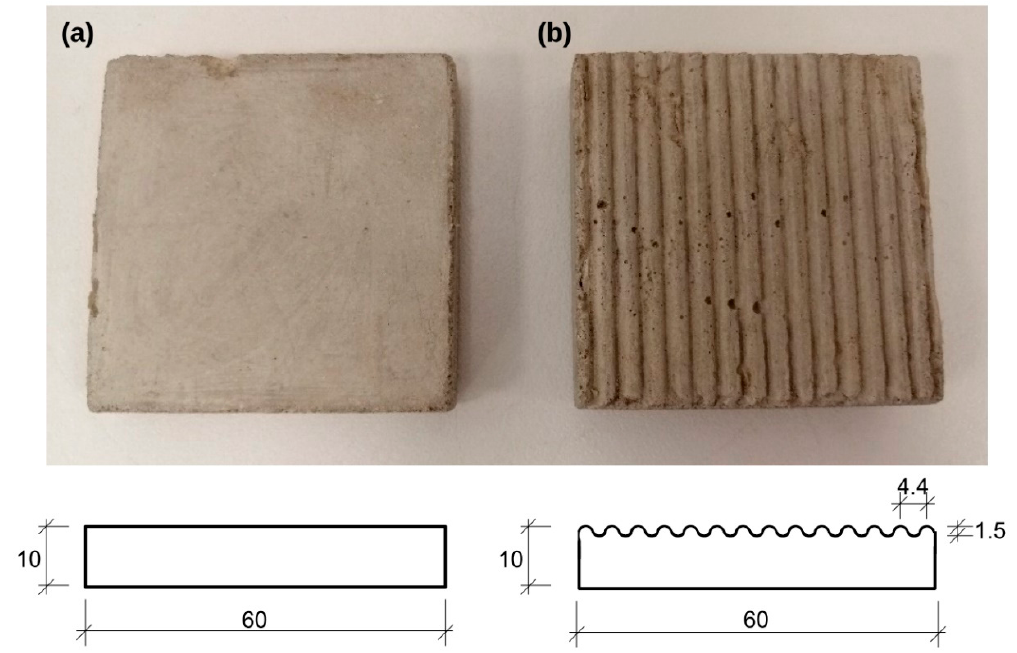
Figure 1. ( a ) Smooth and ( b ) rough concrete interface with idealized geometric scheme.